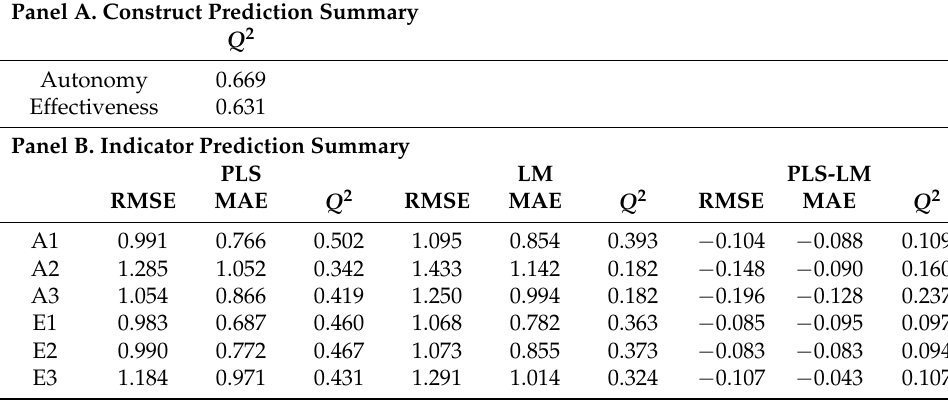
Table 7. PLS predict